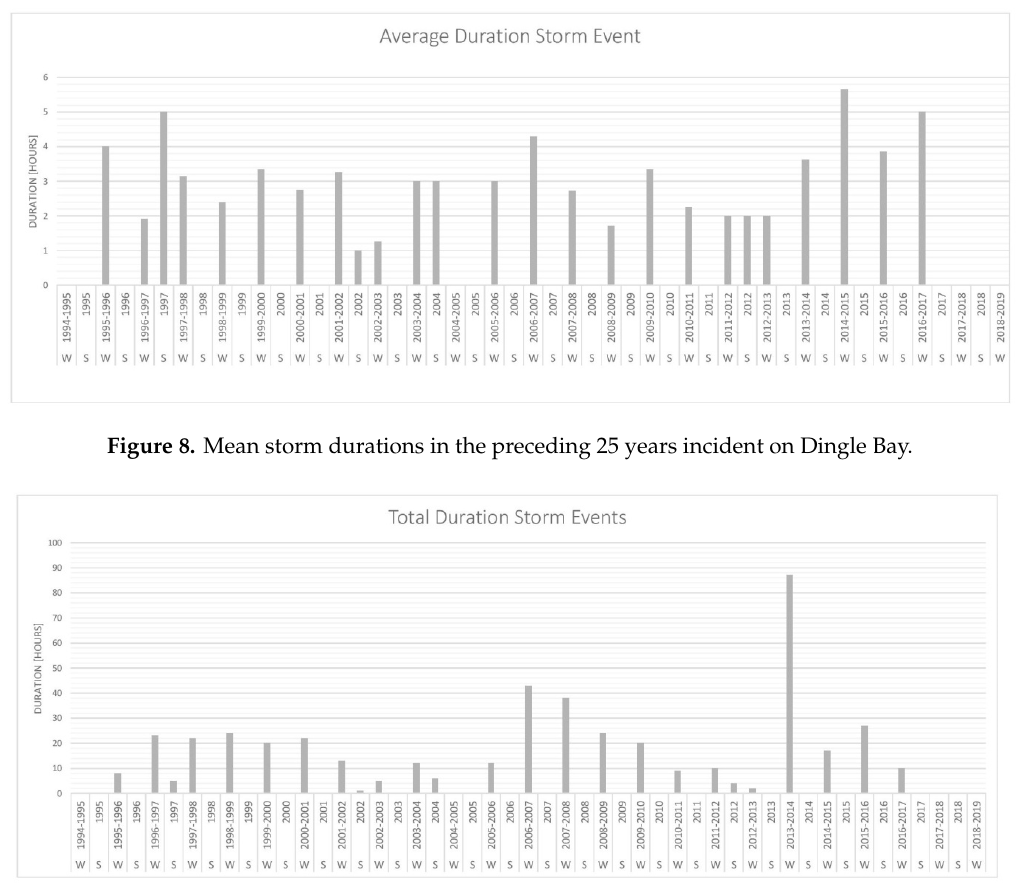
Figure 9. Total duration of storm events in the preceding 25 years incident on Dingle Bay.